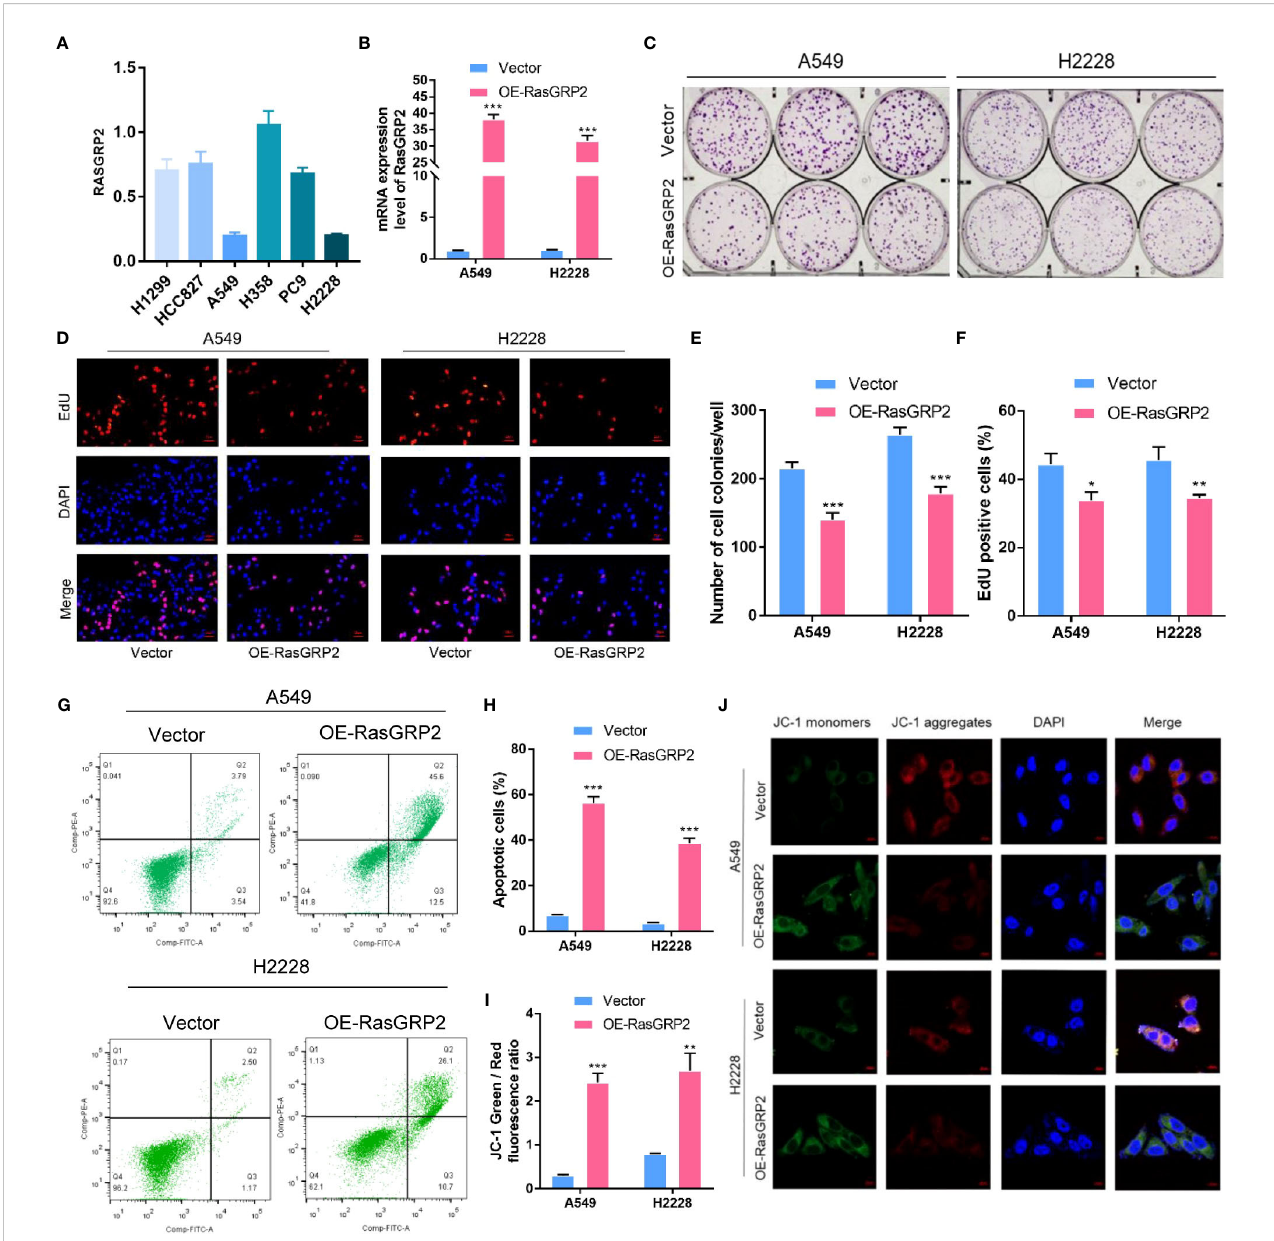
FIGURE 12 Overexpression of RASGRP2 inhibited the proliferation by regulating apoptosis in LUAD. (A) The level of RASGRP2 expression in 6 lung cancer cell lines. (B) RASGRP2 overexpression ef fi ciency was veri fi ed in A549 and H2228 cell lines. (C – F) Clone formation assay and EdU assay suggested that high RASGRP2 inhibited cell proliferation. (G, H) Flow cytometry analysis suggested that overexpression of RASGRP2 promoted apoptosis. (I, J) JC-1 staining suggested that overexpression of RASGRP2 was associated with decreased mitochondrial membrane potential. *** P < 0.001, ** P < 0.01, * P <